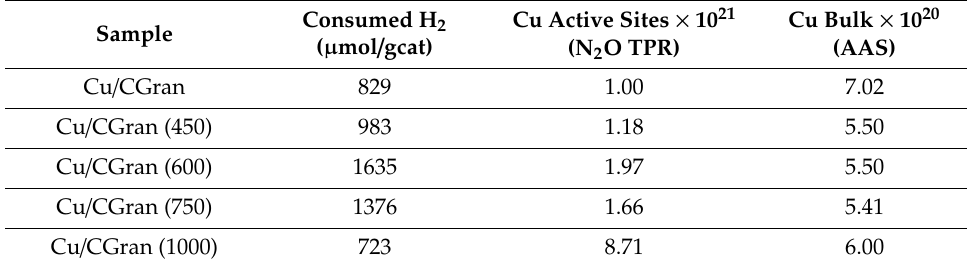
Table 2. Hydrogen adsorption capacity measured by temperature programmed reduction (TPR) of the selectively oxidize surface copper atoms by N 2 O and initial